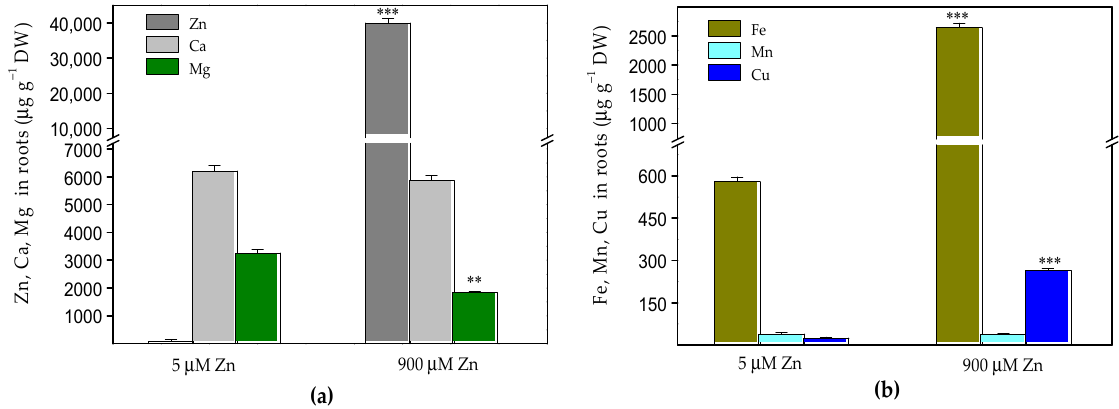
Figure 1. Contents of Zn, Ca and Mg ( a ) and Fe, Mn and Cu ( b ) in Salvia sclarea roots ( µ g g − 1 dry weight (DW)) after 8 days of exposure at 5 µM (control) or 900 µM (excess) Zn. Mean values (±SE) were compared between the two Zn exposures for the same mineral element using a Student’s t -test, and the differences were considered statistically significant with ** p < 0.01 or *** p < 0.001.